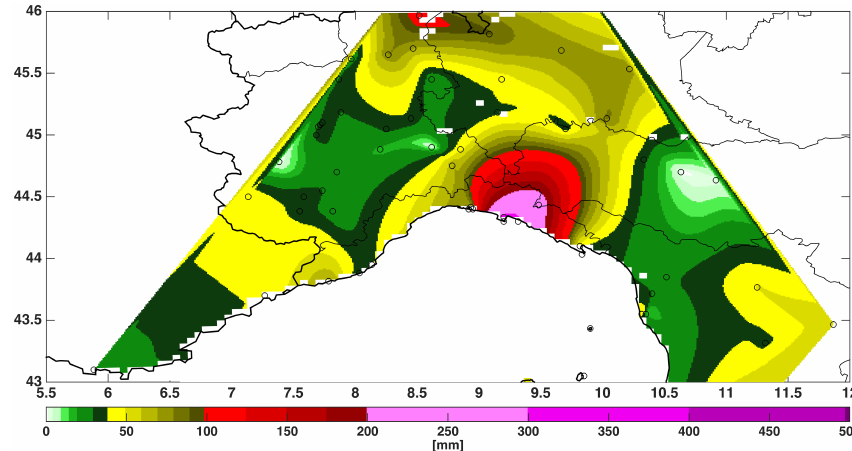
Figure 5. Quantitative precipitation estimates (QPEs) for 07:00UTC 24 September–07:00UTC 26 September 1915.